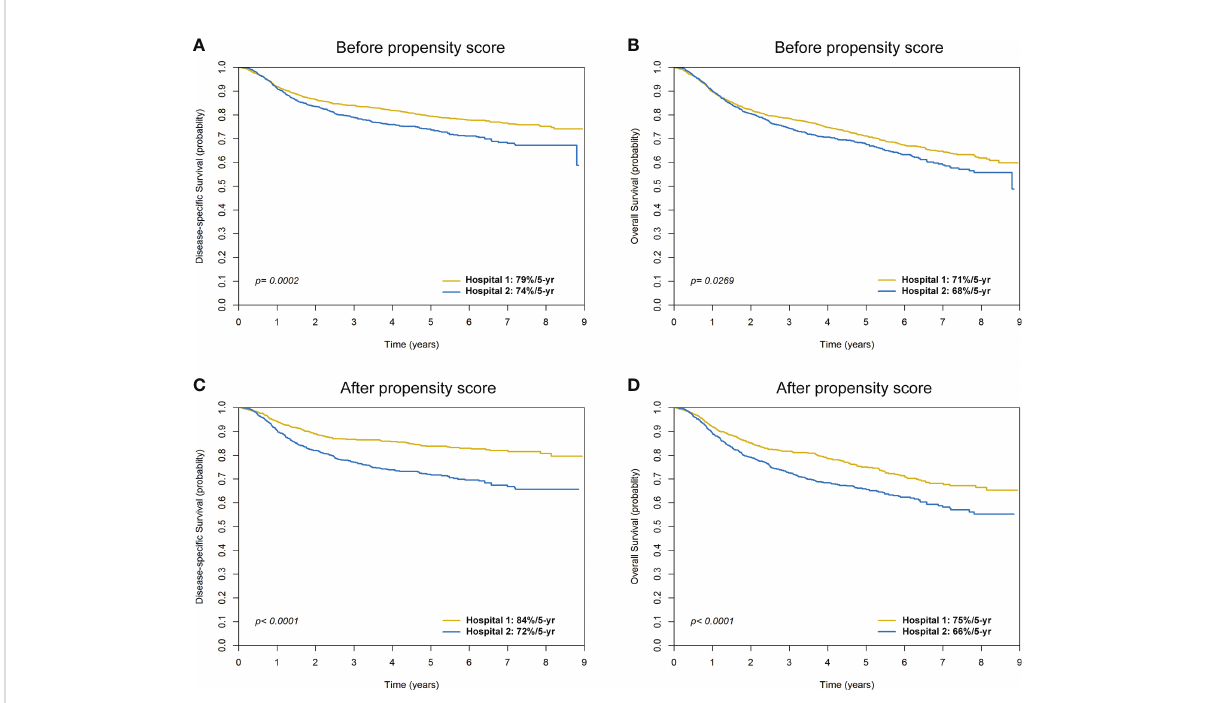
FIGURE 4 Kaplan-Meier plots comparing 5-year disease-speci fi c survival and overall survival for patients with oral cavity squamous cell carcinoma in Hospital 1 and Hospital 2 before (A, B) and after (C, D) propensity score matching.